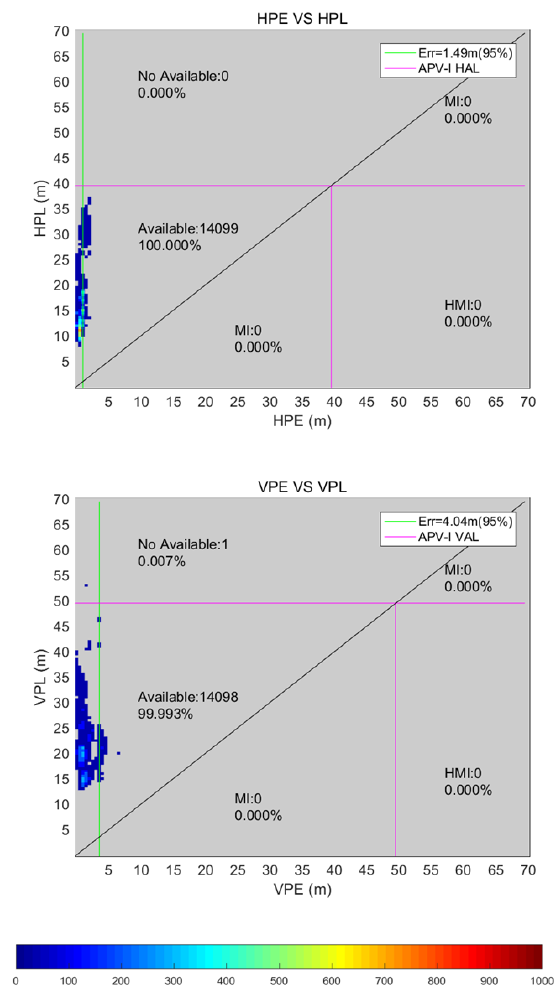
Figure 23. Stanford triangle charts for flight test-III. The top panel and the bottom panel are the